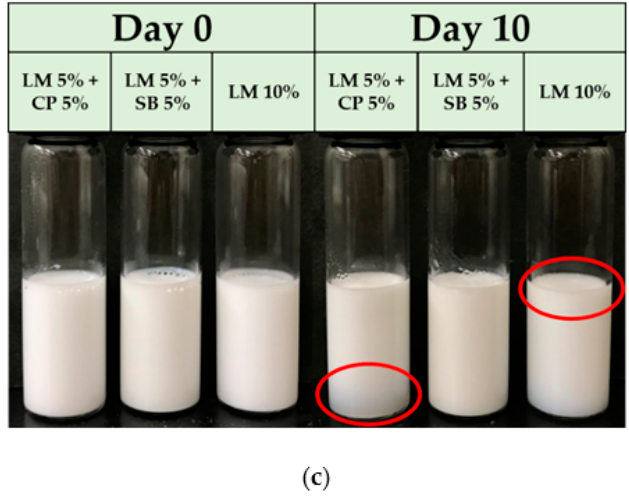
Figure 1. Effect of the dispersed phase in the D-limonene-loaded emulsions. ( a ) Storage stability at 25 °C ( b ) Droplet size distribution of freshly prepared emulsions, and ( c ) The photos of the emulsions on days 0 and 10. The different letters indicate significant differences ( p < 0.05) by Duncan’s test.